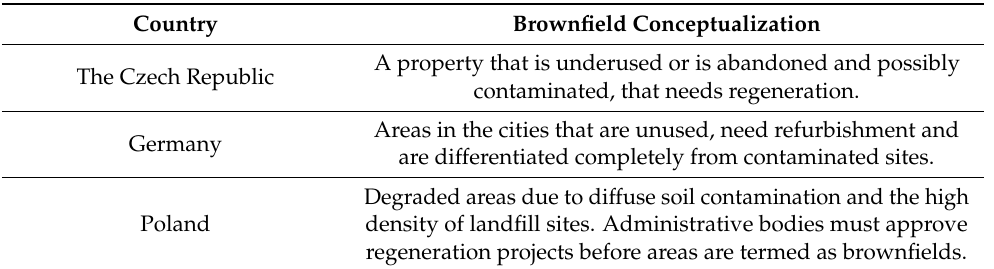
Table 2. Conceptualization of brownfields in the Czech Republic, Germany and Poland. Country Brownfield Conceptualization A property that is underused or is abandoned and possibly The Czech Republic contaminated, that needs regeneration. Germany